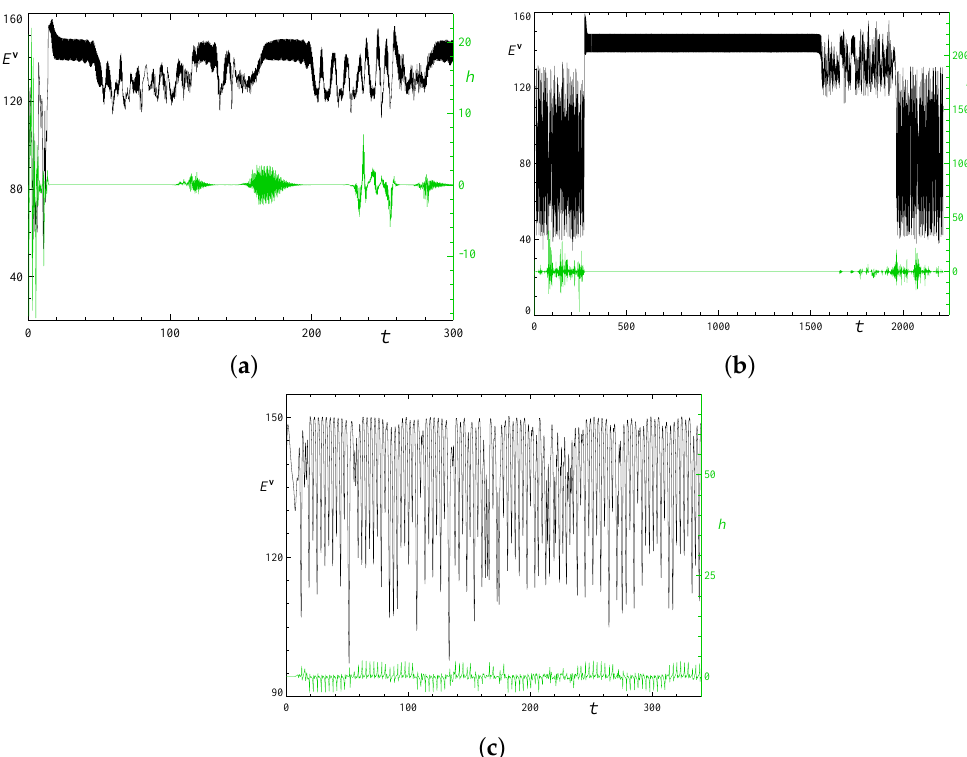
Figure 11. Temporal behaviour of the mean kinetic helicity (green line, right vertical axis) together with the kinetic energy (black line, left vertical axis) for reference in runs 1 x 2.2 (a), 2 x 1.2 (b) and 2 x 1.1